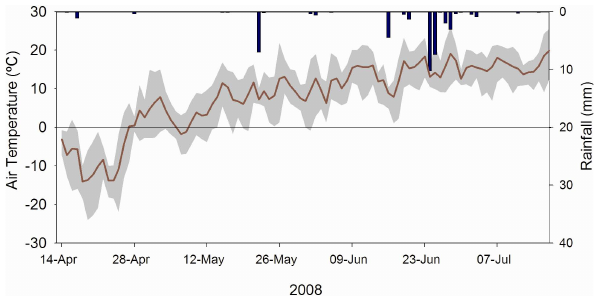
Fig. 2. Mean daily air temperature (range is shown in grey) and total daily rainfall measured at the wetland climate